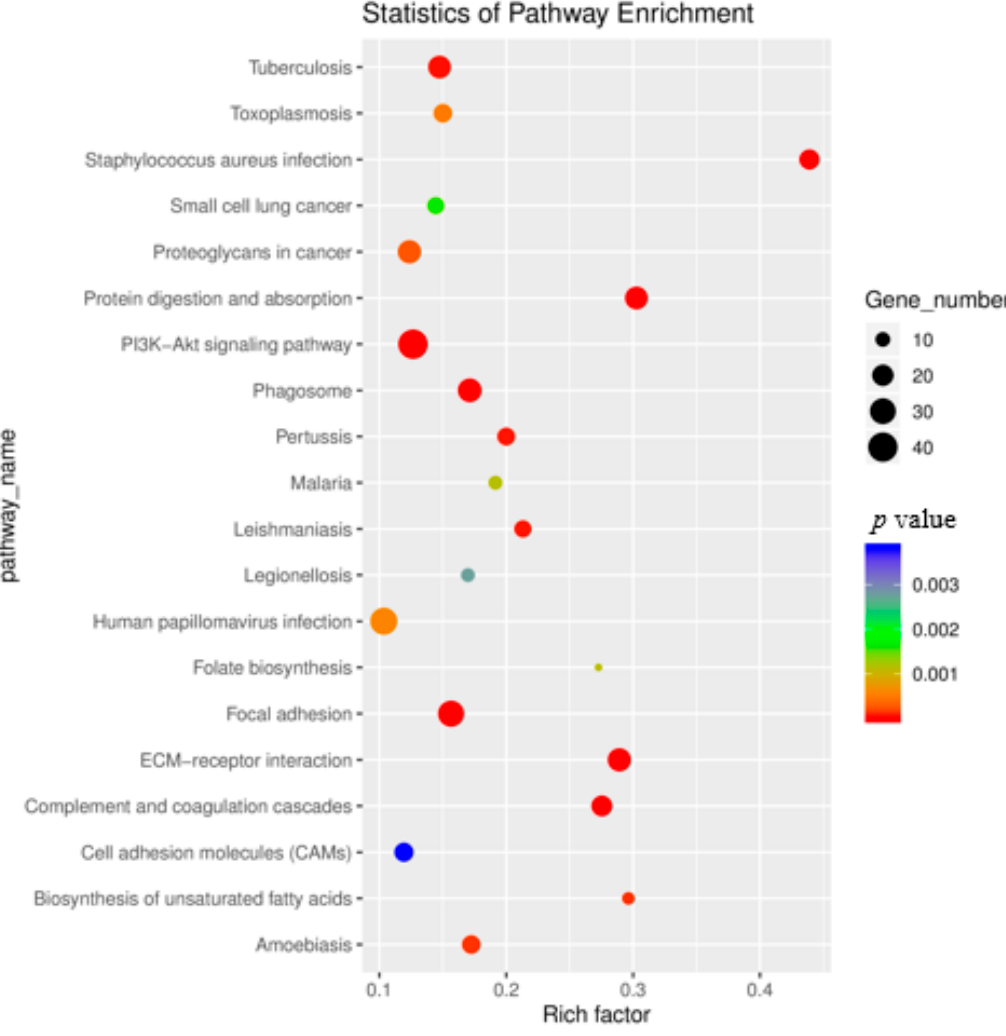
Figure 8. Kyoto Encyclopedia of Genes and Genomes (KEGG) enrichment analysis conducted on significant DE genes. Rich factor is assessed by the ratio of DE genes categorized in a specific KEGG pathway to the total number of genes categorized to the same KEGG pathway; a greater rich factor value indicates a greater degree of KEGG pathway enrichment.